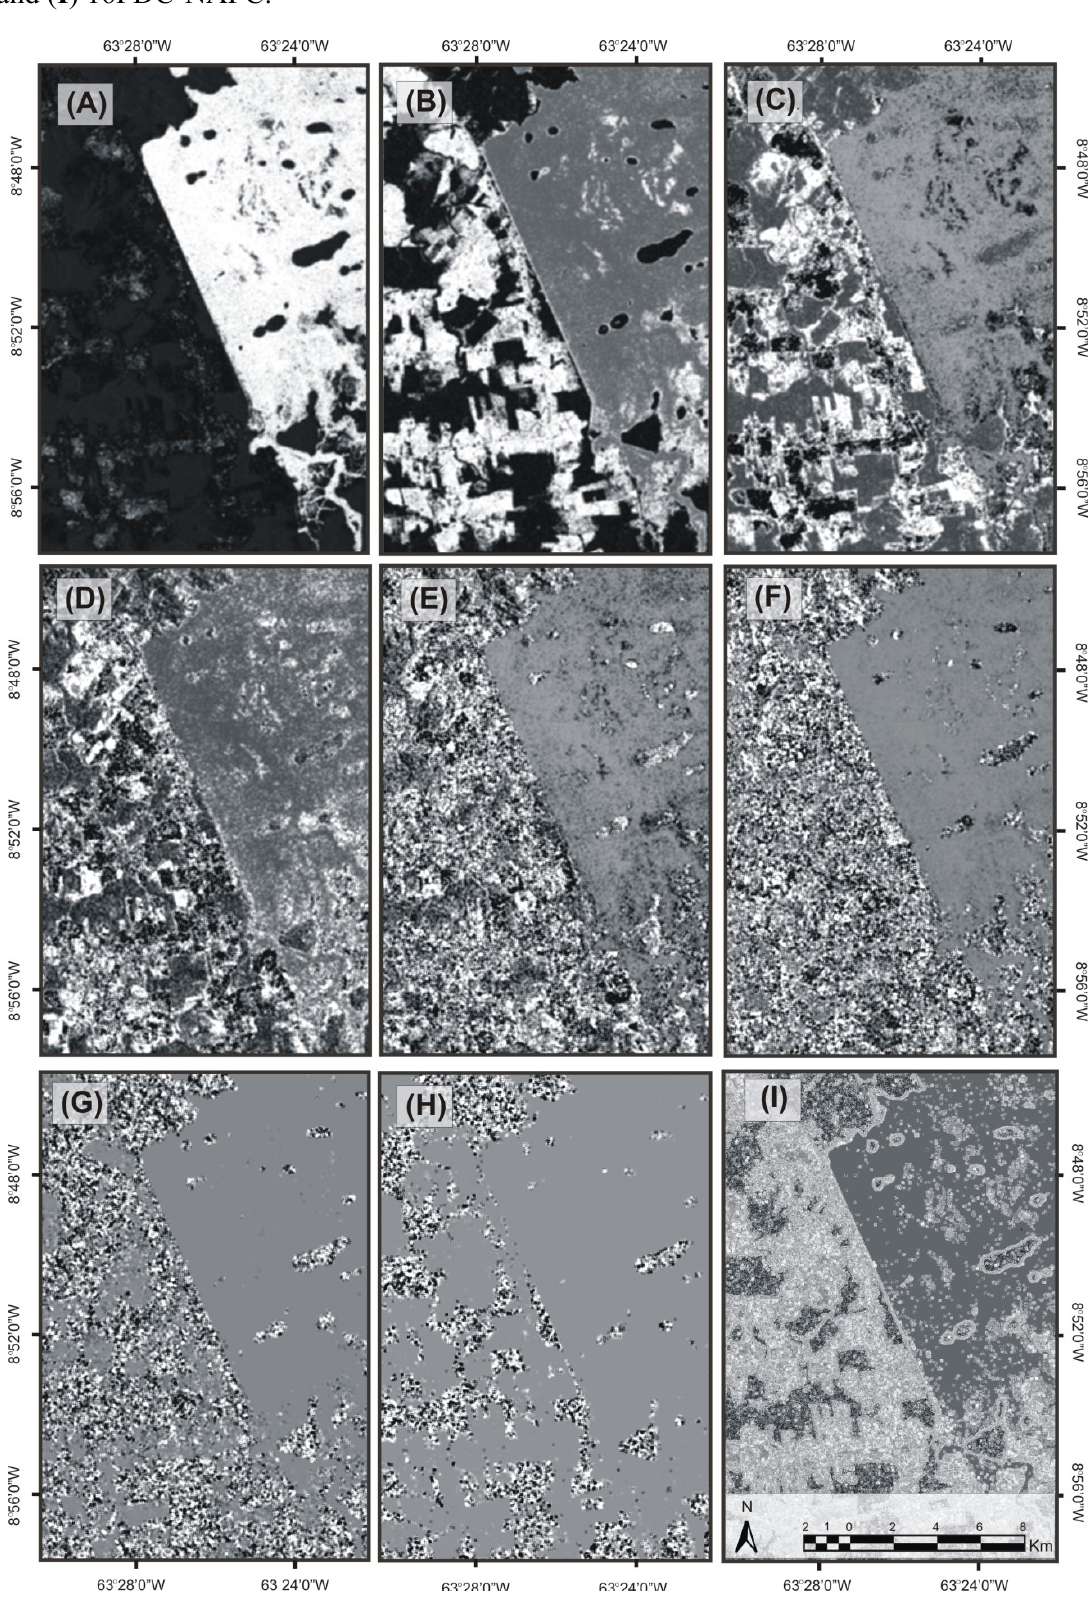
Figure 7. Noise-adjusted principal component (NAPC) transform of the probability